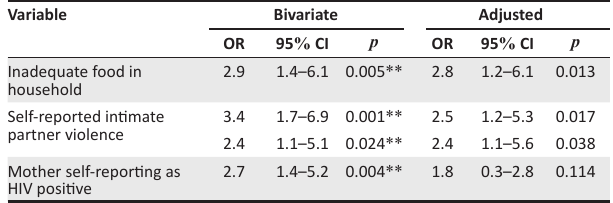
TABLE 3: Factors associated with postnatal depression among study participants ( N = 192). Variable